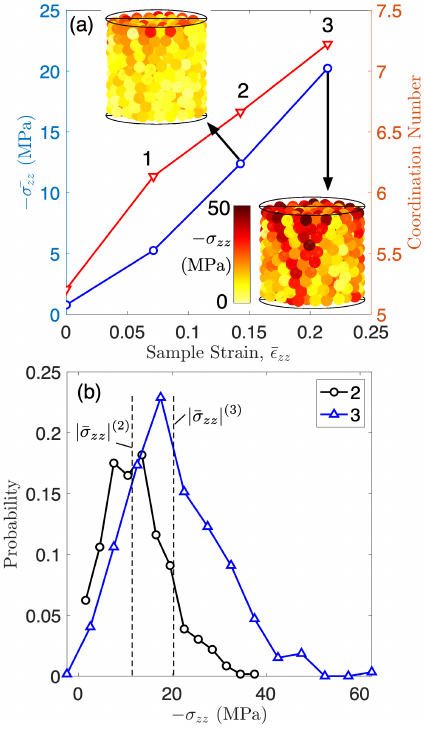
Figure 1. (a) Stress-strain curve of DEM simulation. (b) Distri- bution of  zz in all particles at steps 2 and 3. The small colored line at the bottom of the plot conveys the average over all parti- cles at steps 2 and 3.